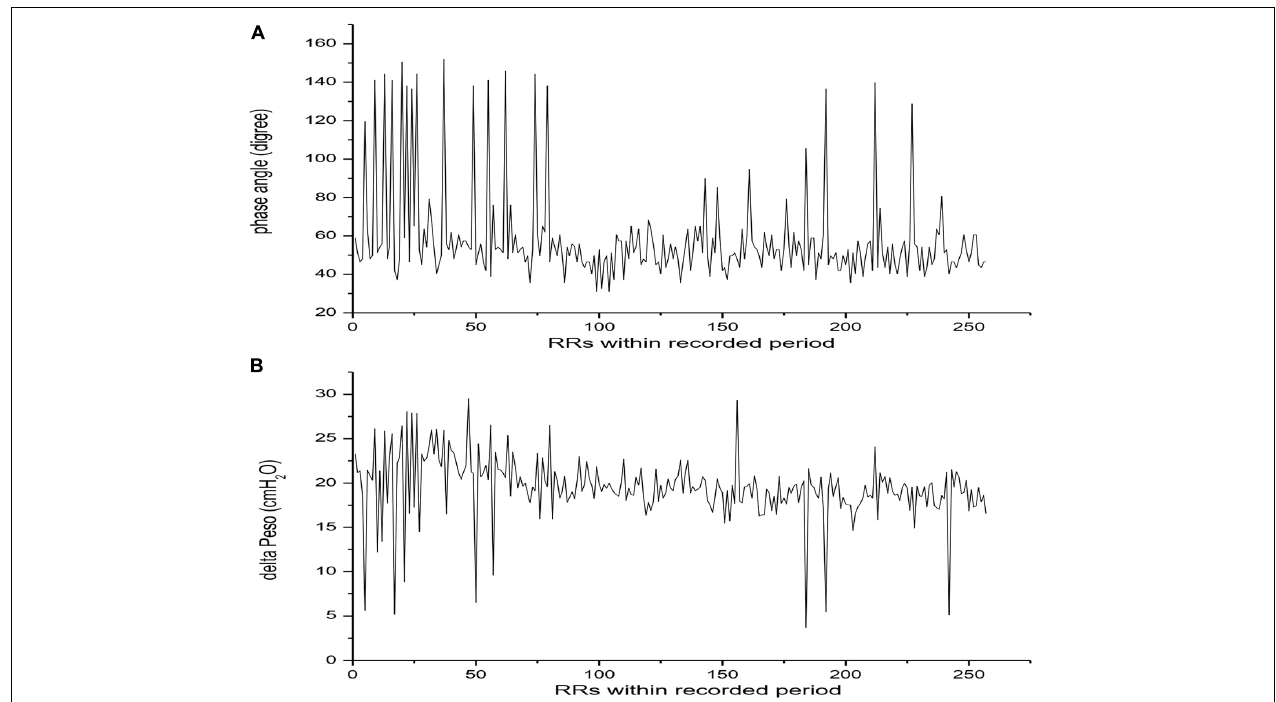
FIGURE 1 | Phase angle and esophageal pressure fluctuation breath by breath in stable reverse trigger epochs acquired in patient 2. Panel (A) showed Phase angle fluctuation breath by breath. Panel (B) showed the maximal inspiratory muscle pressure fluctuation during reverse trigger breath by